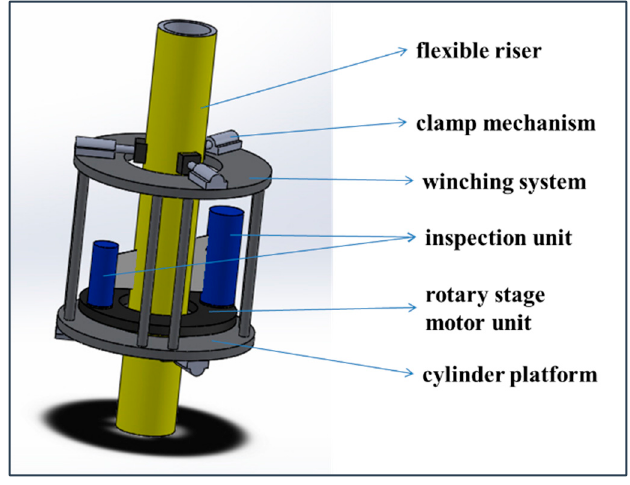
Figure 1. 3-d concept model of the robotic inspection system.